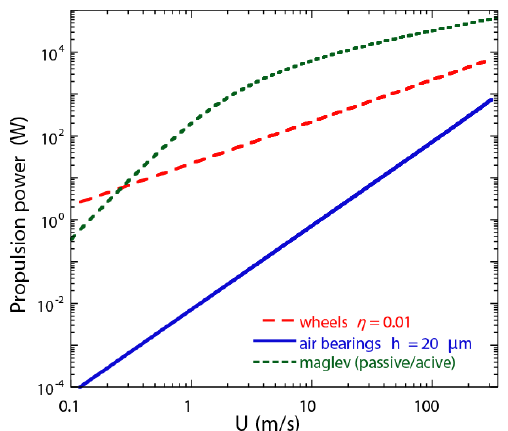
Figure 13. Propulsive power comparison for all four types of levitation for a 2200-N Hyperloop pod. Air bearings (with 20 μm gap height), wheels with a 0.01 coefficient of rolling friction, passive and active magnetic levitation systems (common curve).